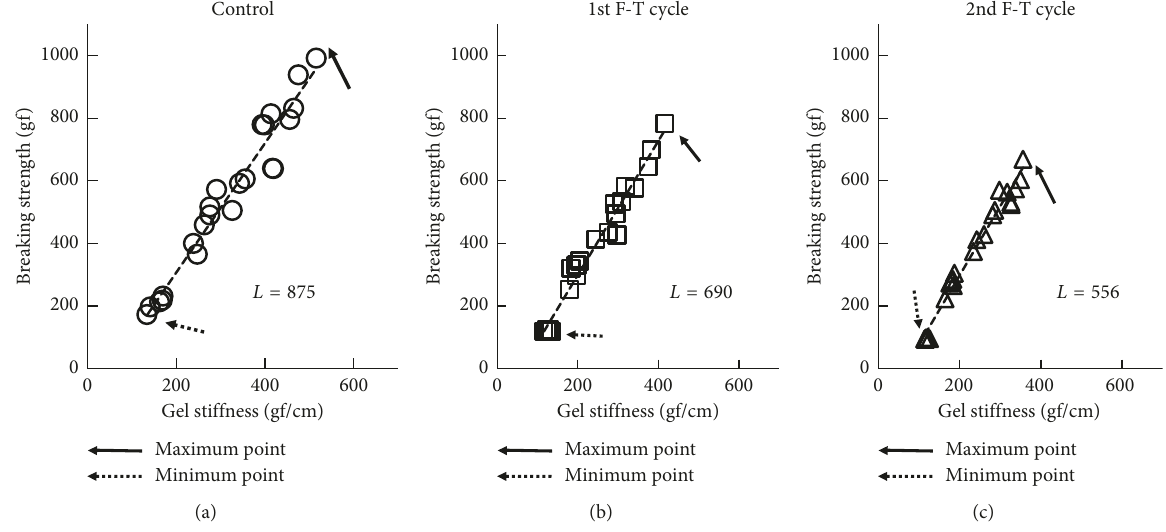
Figure 3: Relationship between breaking strength and gel stiffness of suwari gel prepared from each frozen surimi sample. L value indicates the approximate length of the straight line from the minimum point to the maximum point. Minimum point and maximum point were defined as the shortest distance and longest distance from the origin,